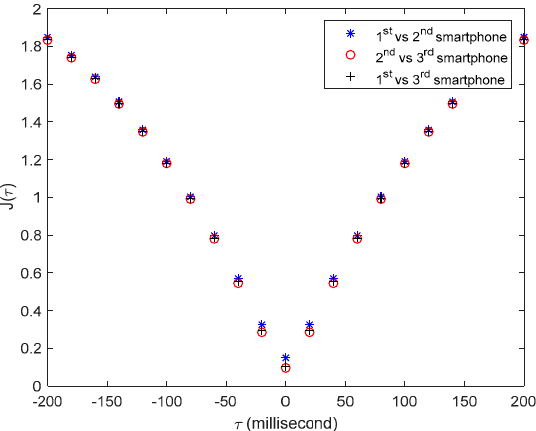
Figure 13. Time synchronization indexes 𝐽(𝜏) among there tested smartphones.